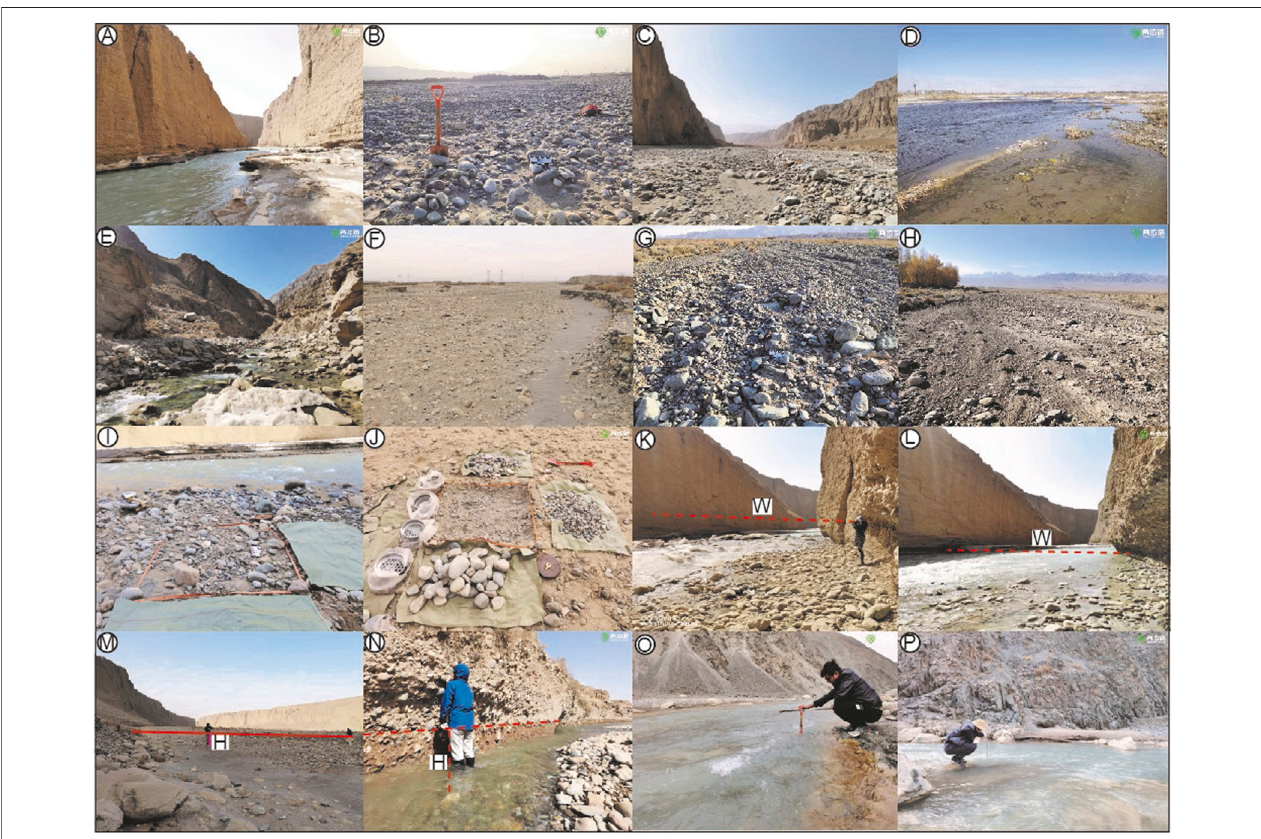
FIGURE 2 | Field photos from the Beida River catchment. (A) and (B) Two kinds of Taolai River channels. (C) and (D) View of the Hongshuiba River channel characterized by deep incision and low relief, respectively. (E) and (F) the Fengle River channel. (G) and (H) Ephemeral channels overlying the inter fl uves between the Taolai,Hongshuiba,andFengleRivers. (I) and (J) Samplesiteillustratinginvestigationmethodsinthe fi eld. (K) and (L) Fieldmeasurementofriverbedwidth. (M) – (P) Field measurement of riverbed depth.